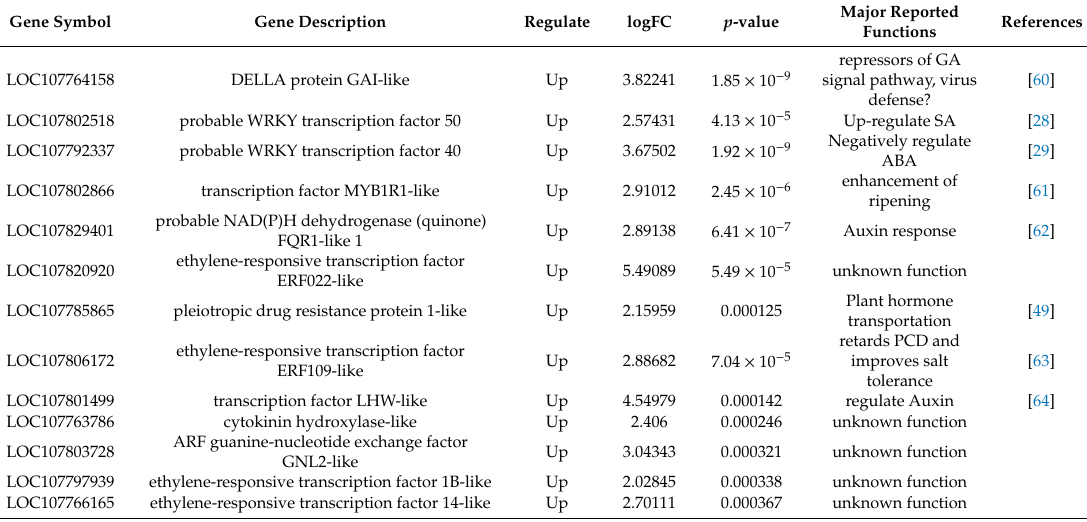
Table 4. Phytohormone responsive genes induced by